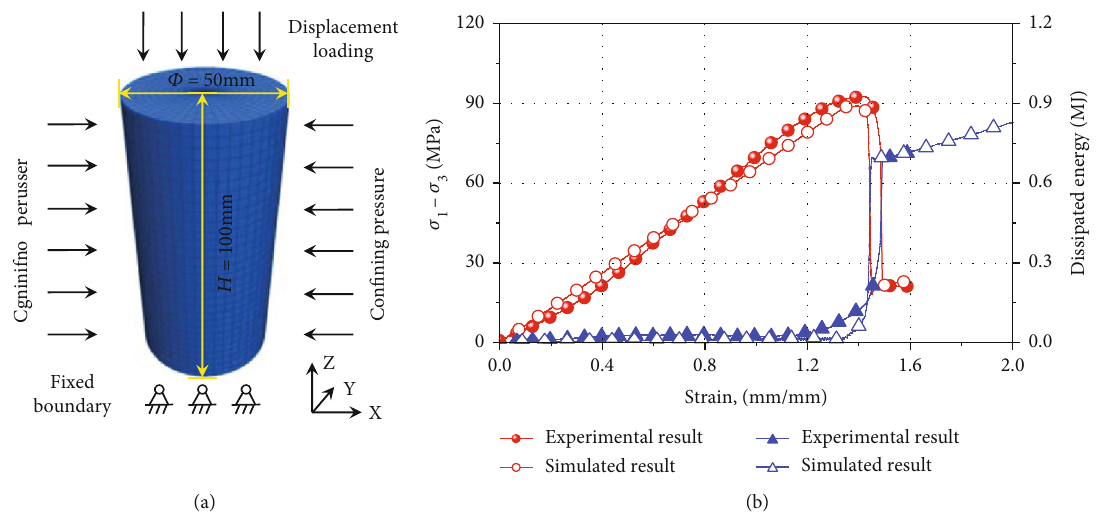
Figure 3: Comparisons between the numerical simulation and laboratory test. (a) Represents the numerical model of rock samples. (b) Gives the stress-strain and dissipated energy-strain curves obtained from numerical modeling and laboratory test, respectively.